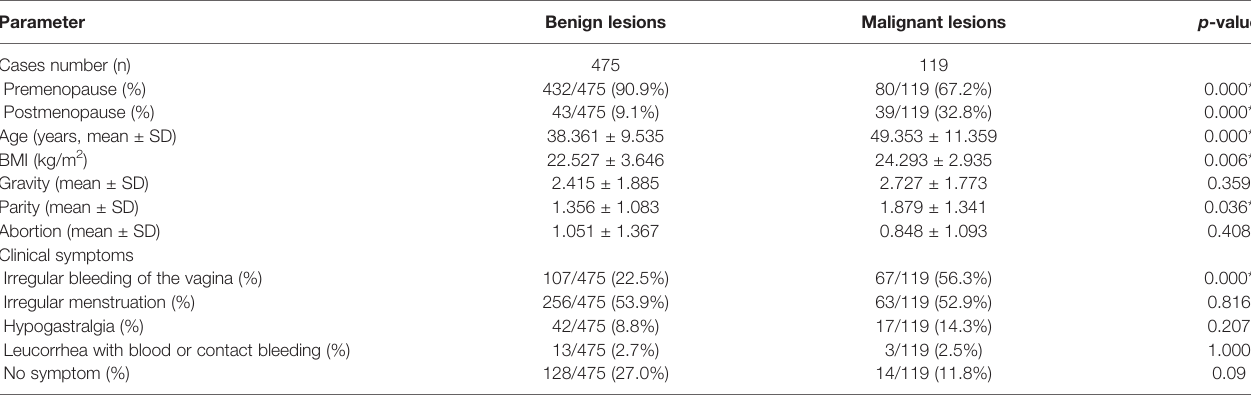
TABLE 3 | Demographic and clinical variables of the study